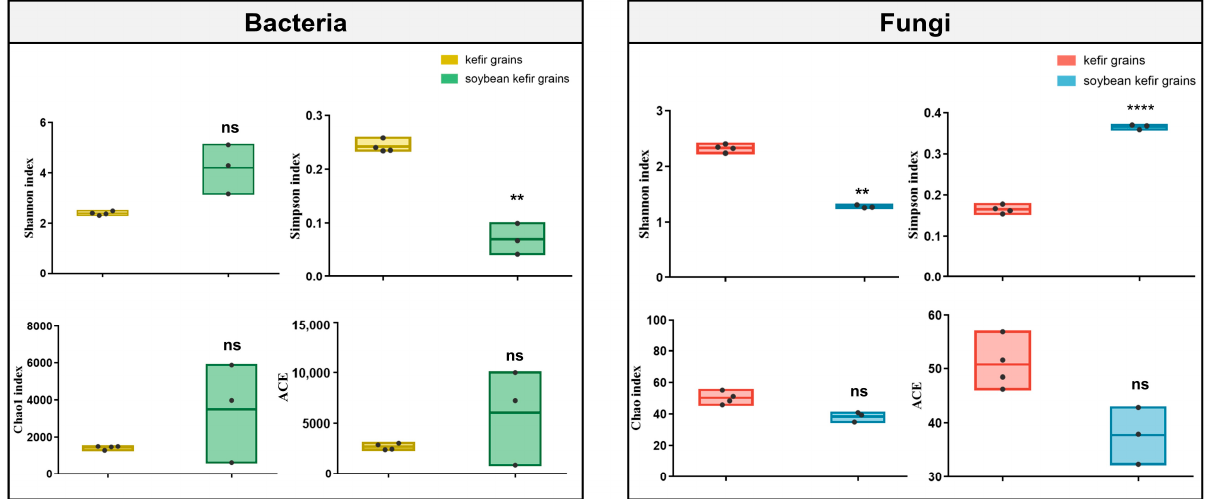
Figure 2. Alpha diversity indices in kefir grains and soybean kefir grains. The significance was denoted by asterisks. ** p < 0.01, **** p < 0.0001, and ns indicates no significance.